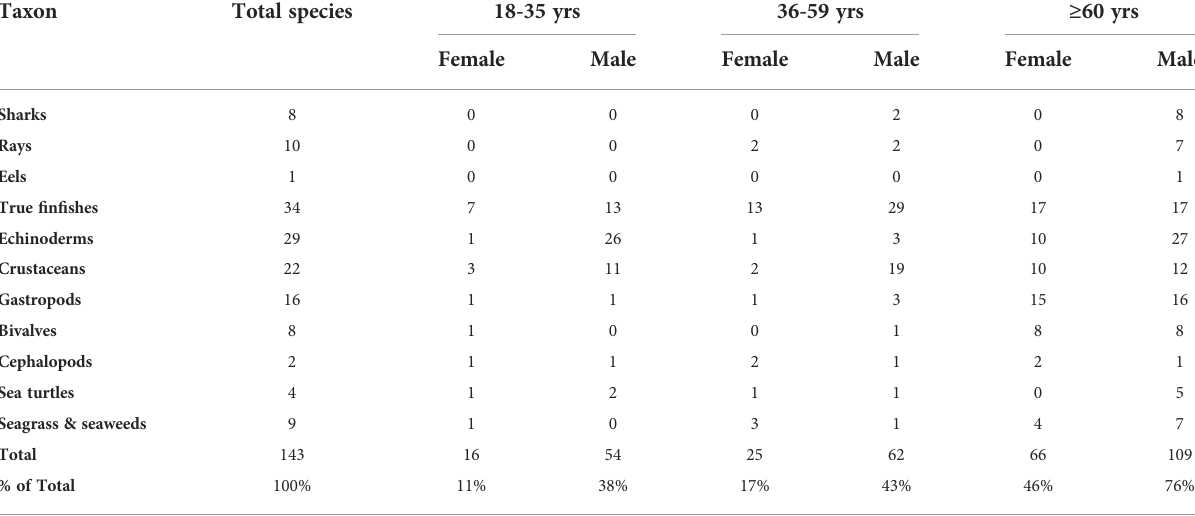
TABLE 4 Age and sex breakdown of number of species identi fi ed by fi shers for different taxa.